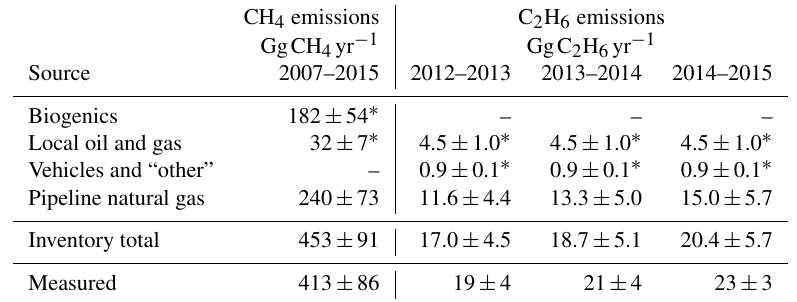
Table 1. Emissions inventories for CH 4 and C 2 H 6 . Only one methane emission value is included, which is the mean emissions over the 2007–2015 measurement period. Ethane emissions are from the Caltech measurements only, and each column of the table contains data from September through August. Emissions marked with an asterisk ( ∗ ) are from Peischl et al. (2013) for 2010. The pipeline natural gas emissions of ethane are computed by multiplying the methane emissions from the pipeline natural gas (58% of the measured total CH 4 ) by the increasing slope fitted to the ethane to methane ratios measured by the Caltech instrument. Uncertainties on the “measured” emissions are the standard deviations of the monthly emissions computed for the time range.